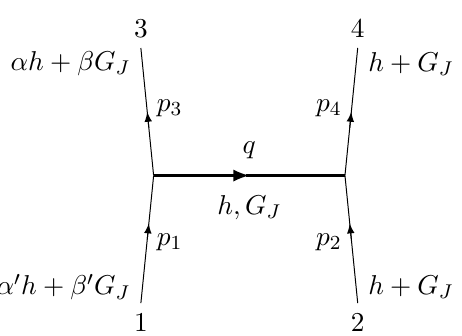
Figure 7 . Graviton interference bound: in-states are linear combinations of G J and the graviton h . Graviton interference